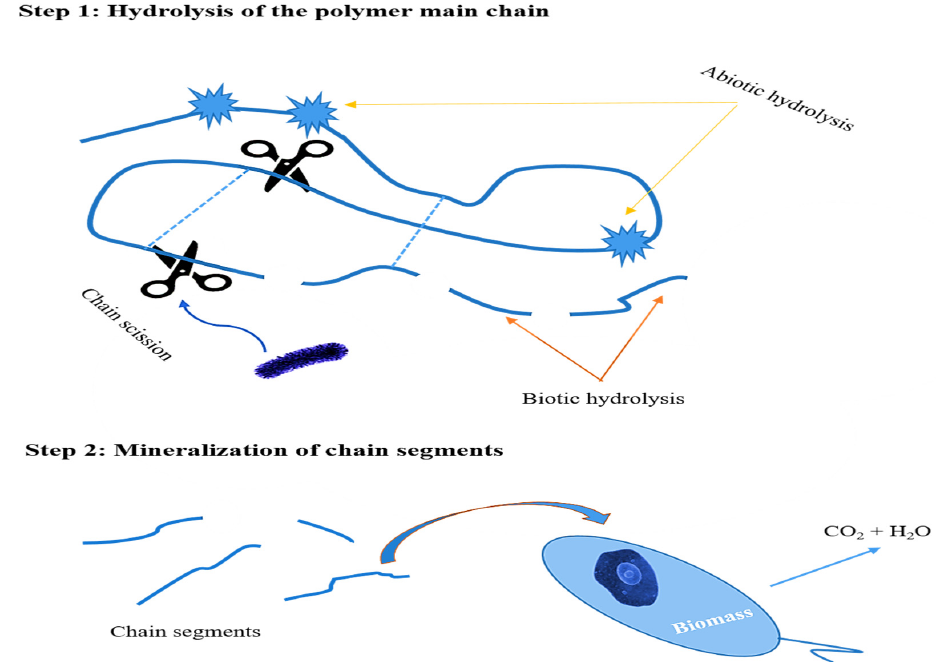
Figure 8. Schematic representation of the expected degradation process for